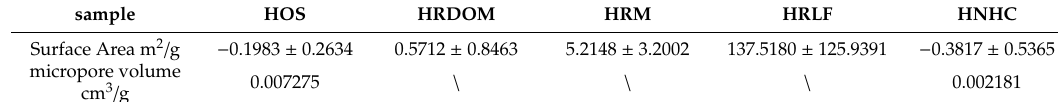
Figure 7. The micro-structure of: ( a ) HOS; ( b ) HRDOM; ( c ) HRM; ( d ) HRLF; ( e ) HNHC.